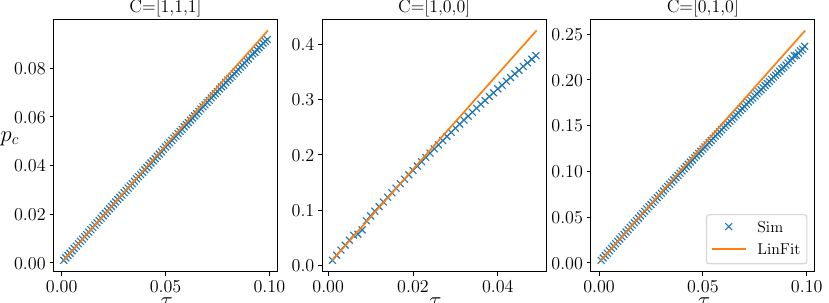
Figure 3. The dependence of the synchronization threshold on the intermittent parameter k such that τ = k ∆ t for different coupling directions and its linear fit obtained using the first 20 time steps. The other parameters of the simulation are: dt = 10 − 3 and k max = 50 for C = [ 1,0,0 ] , k max = 100 for the